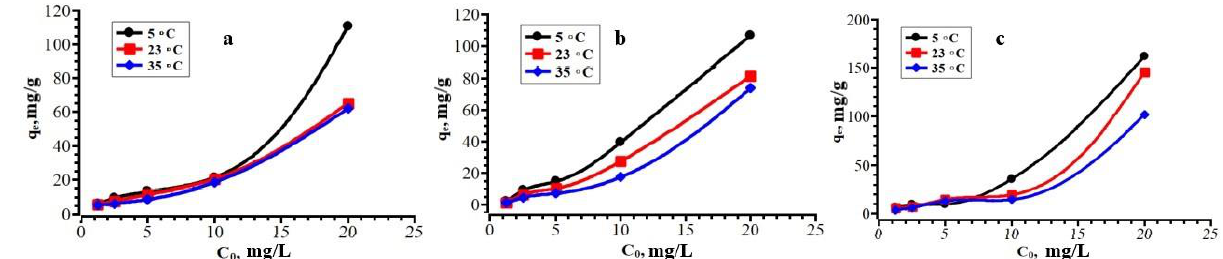
Figure 9. Dependence of the value of solid phase extraction on the initial concentration of CZO ( a ), CTX ( b ) and CRO ( c ).